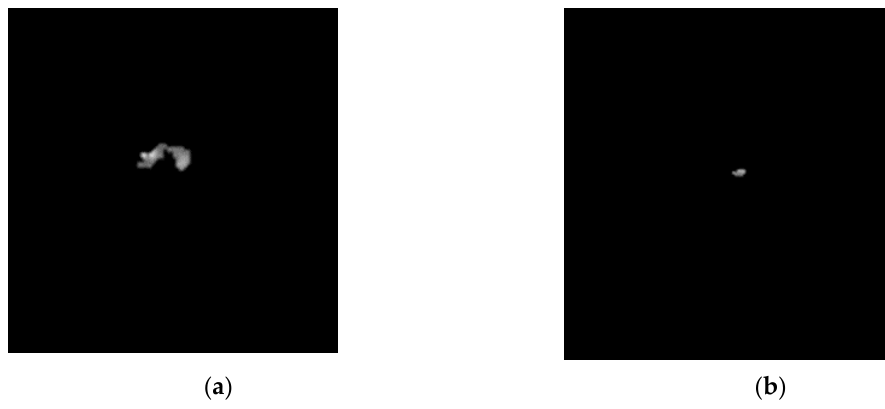
Figure 4. Comparison of intensity mapping of target in two sequential frames. ( a ) Frame 10; ( b ) Frame 11.